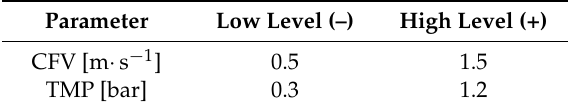
Table 1. Experimental setup showing orthogonal combinations of CFV and